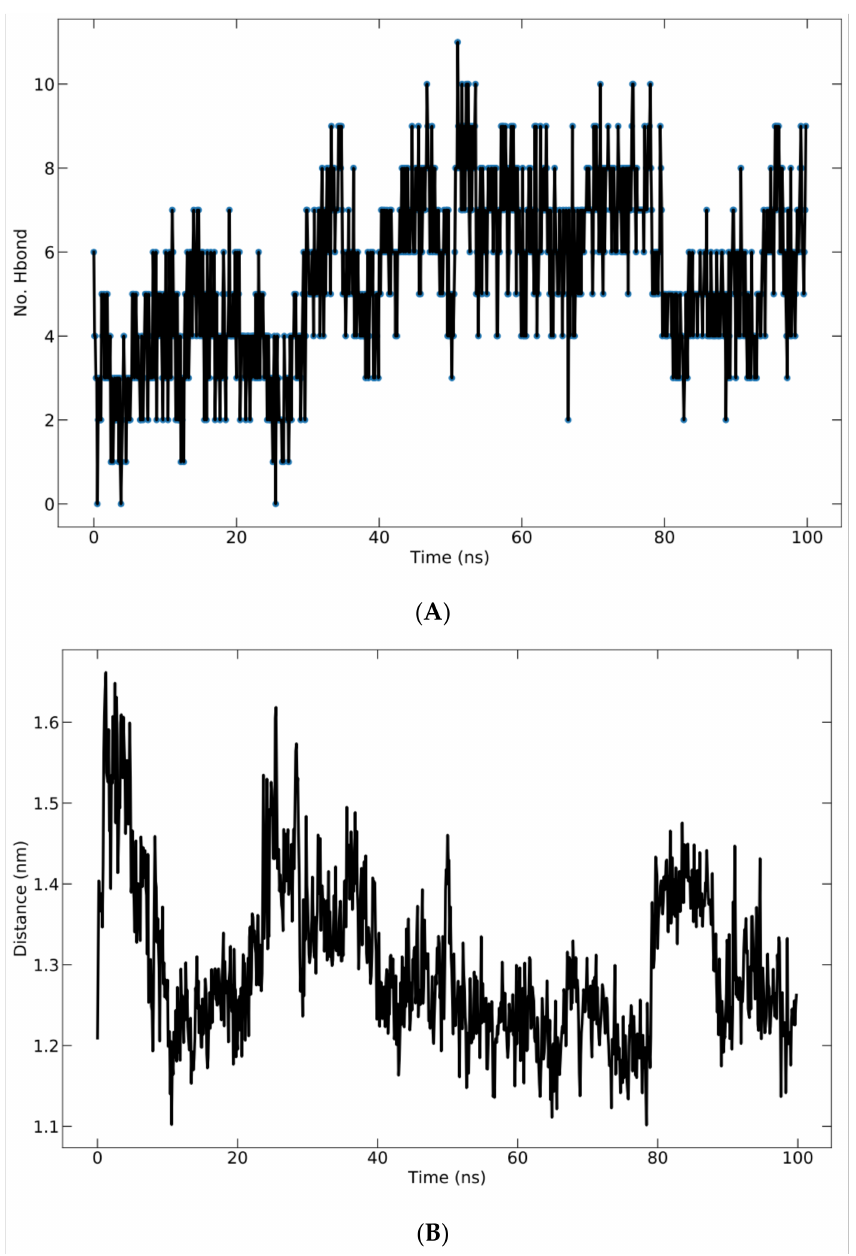
Figure 7. ( A ) Hydrogen bonding of protein–ligand complex; ( B ) average distance between peptide and protein during 100 ns